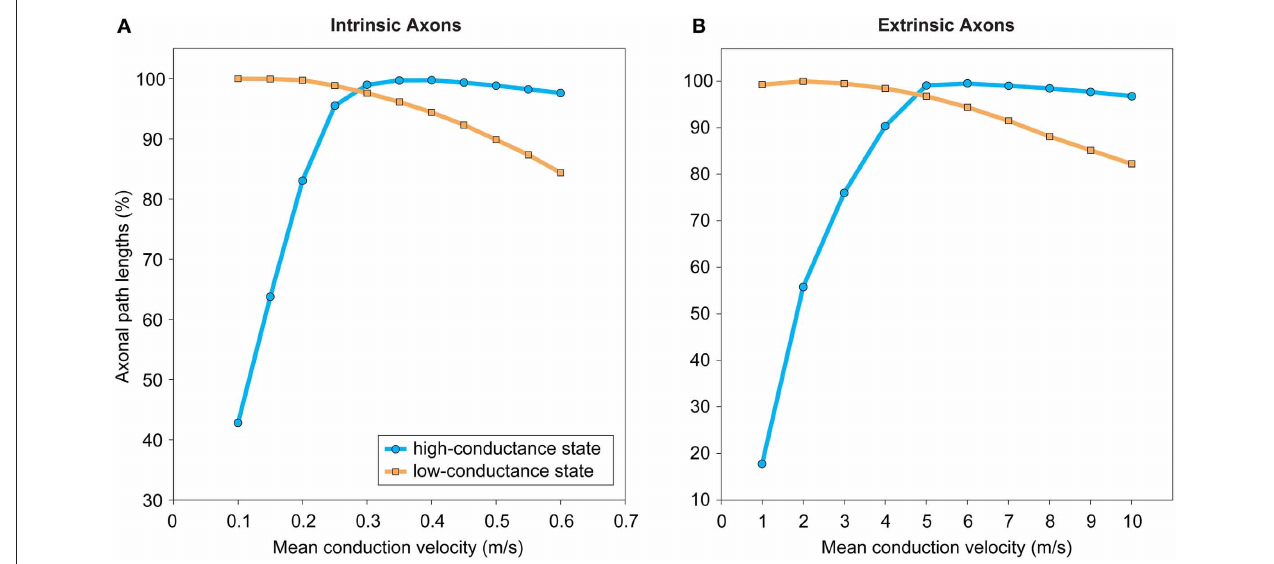
FIGURE 7 | Most estimated intrinsic and extrinsic axonal conduction delays are within an order of magnitude of neuronal integration delays apart from when axons conduct at their slowest rate and neurons operate in a high-conductance state. (A) Intrinsic axon path lengths of